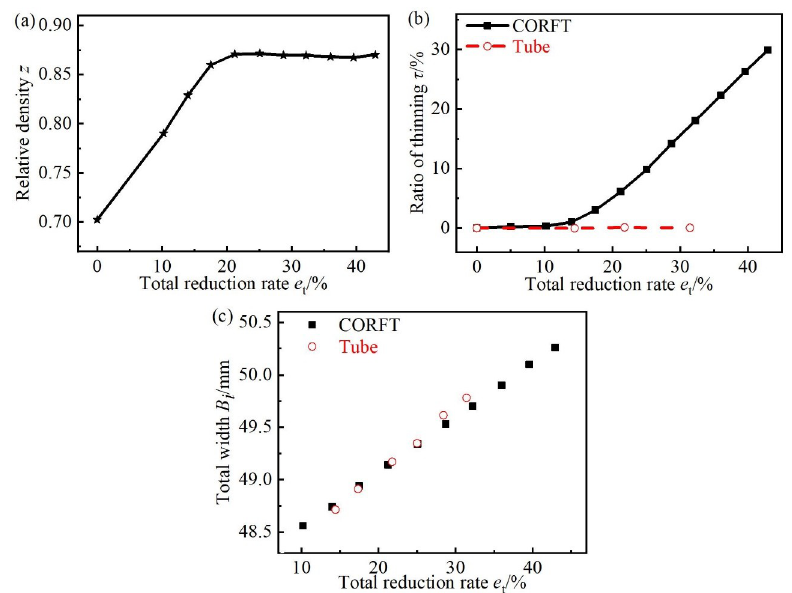
Fig 8. Parameters deduced by the flat rolling experiments. (a) Relative density of the CORFT, (b) ratio of thinning for the CORFT and the tube, and (c) total width of the CORFT and the tube.